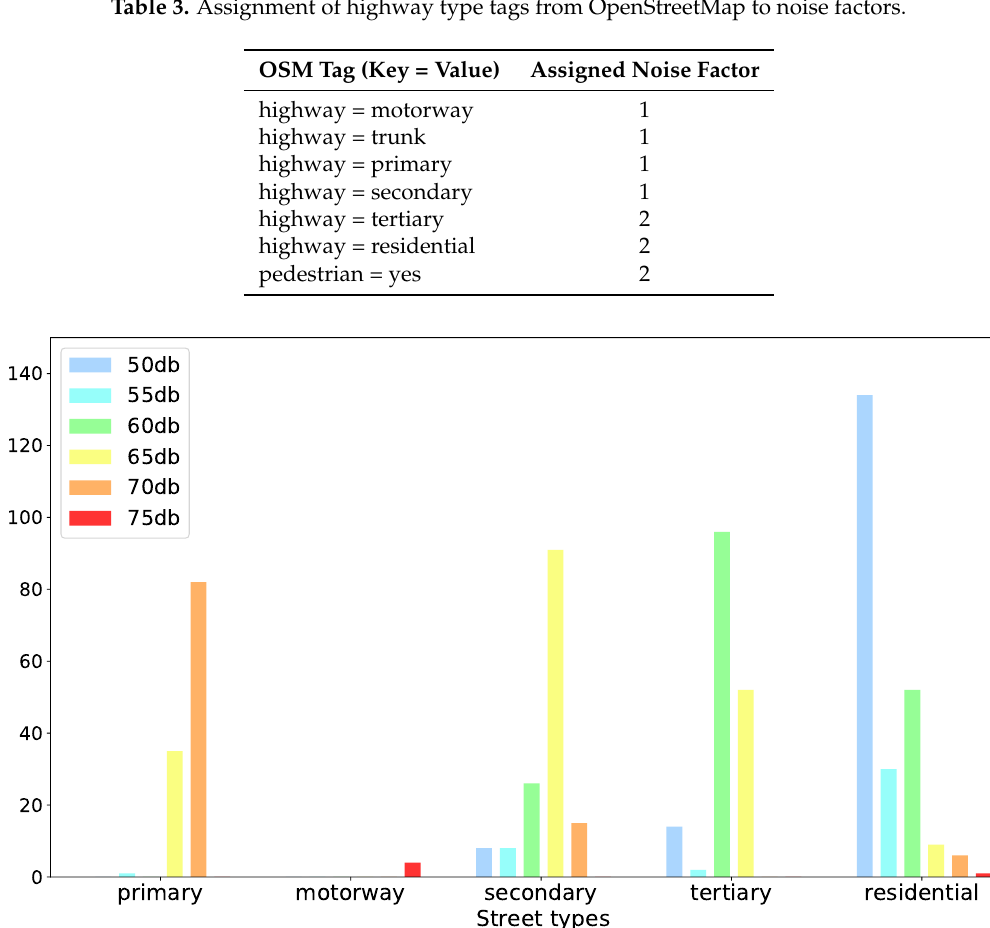
Table 3. Assignment of highway type tags from OpenStreetMap to noise factors.